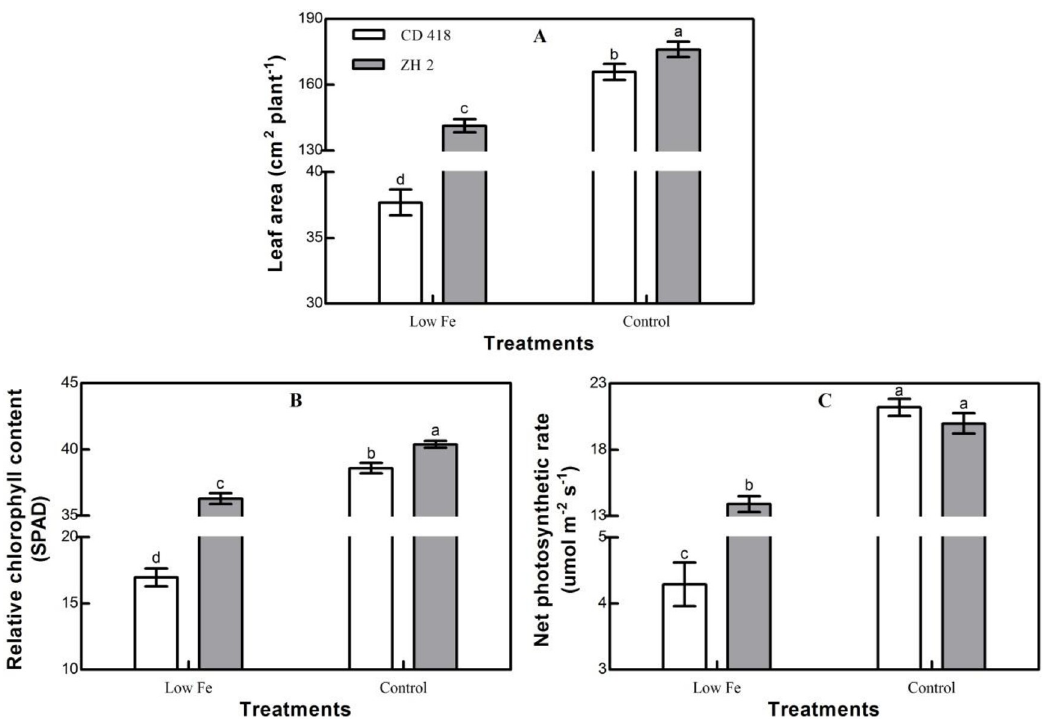
Fig 5. Photosynthetic characteristics (leaf area, relative chlorophyll content, and net photosynthetic rate) of two maize cultivars grown under different Fe concentrations. Data are the mean ± SE of three replicate pots. Values with different lowercase letters are significantly different at p <